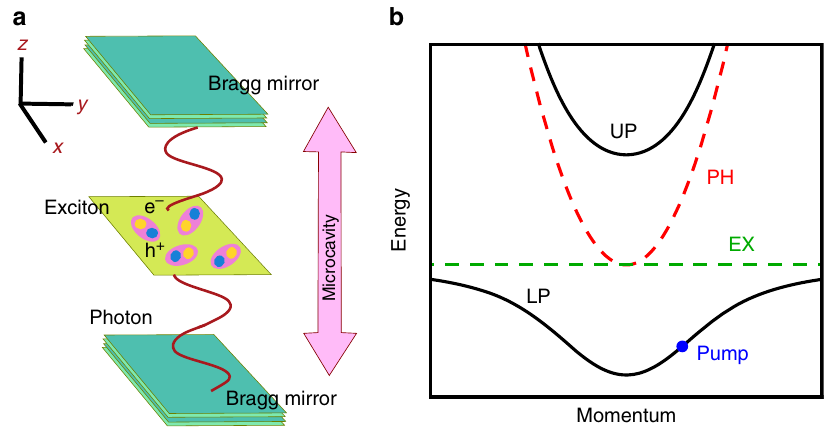
Fig. 1 Polaritons in semiconductor microcavities. a Polaritons are quasiparticles formed when cavity photons, which are massive due to con fi nement in the z direction between two Bragg mirrors, interact strongly with excitons con fi ned in a quantum well. Polaritons are free to move in the two-dimensional plane perpendicular to their con fi nement. b The excitonic dispersion (dashed green) is approximately constant compared to the photonic (dashed red) due to the much larger exciton mass. Strong coupling leads to anticrossing and the formation of upper and lower polariton branches (solid black). Polaritons interact because of their excitonic component, while their photonic part causes decay and the need for an external drive. A coherent laser pump resonantly tuned to the polariton dispersion is marked by a blue